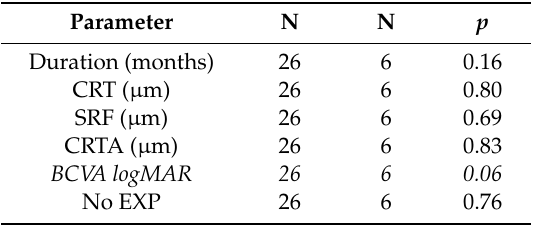
Table 8. Comparison between the baseline parameters of good responders and nonresponders to SMPLT according to the Mann–Whitney U